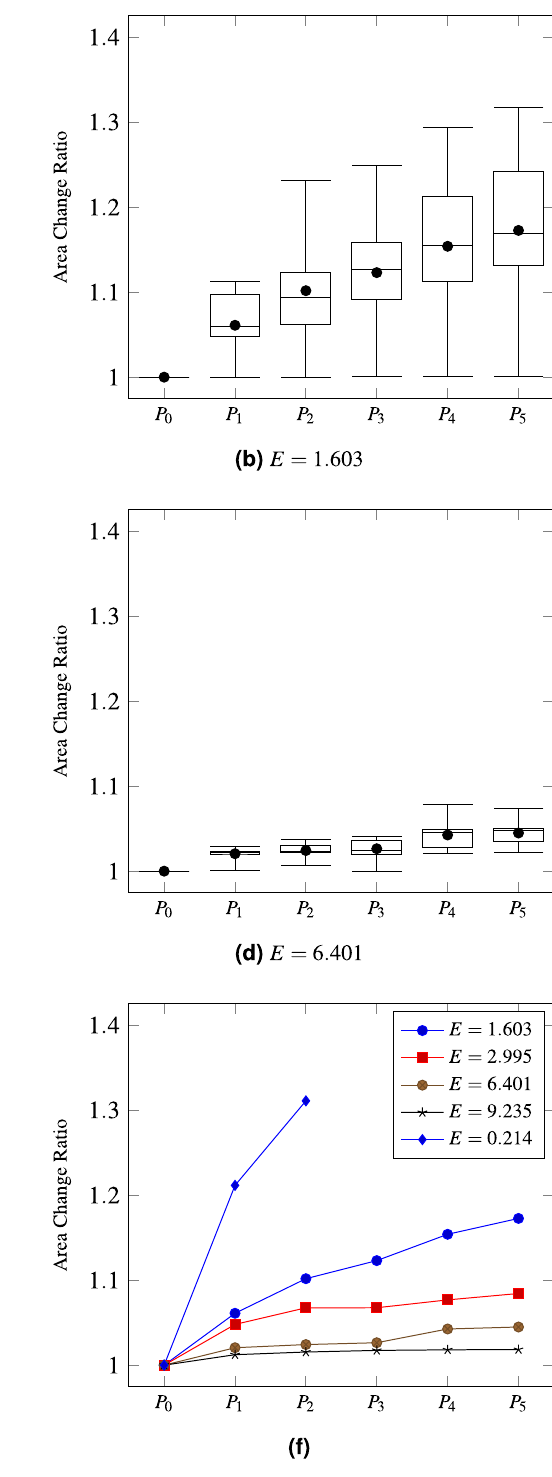
Figure 6. Distributions of area change ratios of beads according to their Young’s moduli. ( a – e ) present manually measured area change ratios of the five types of beads (20 beads for each type), E 2.995, 6.401, and 9.235, respectively, in the same manner with Fig. 2 ( a , b ). ( f ) shows a comparison between the average area change ratios of each bead. The six figures exhibit that area changes of beads are not linearly proportional to pressure levels, as with live